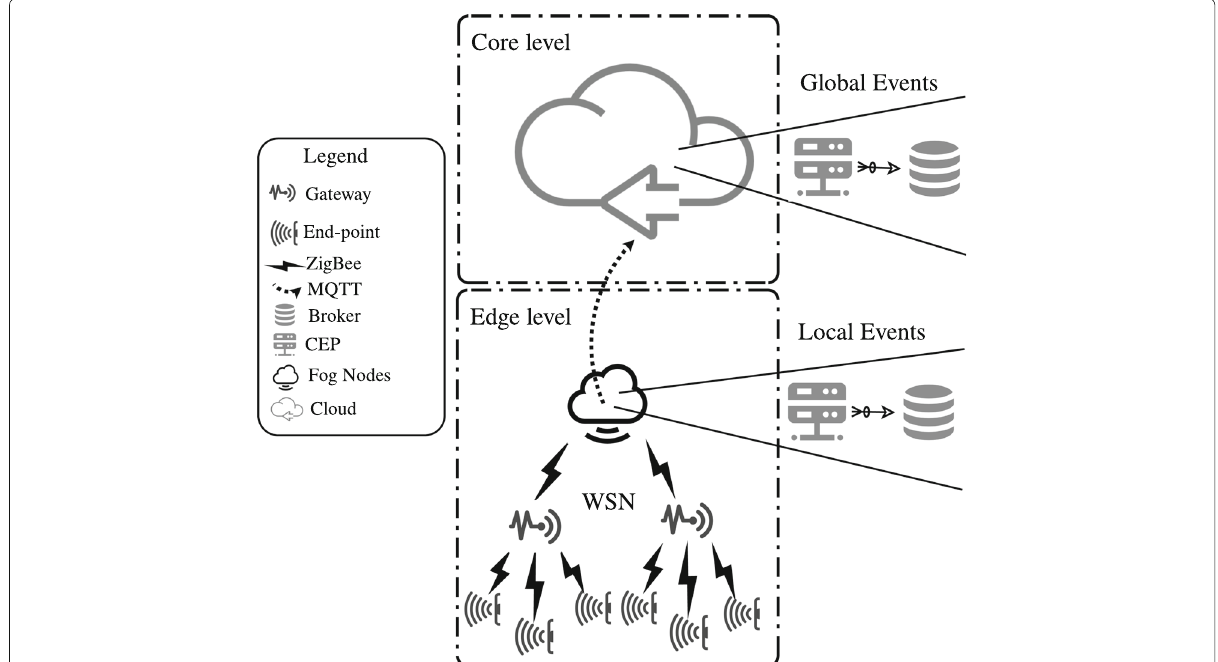
Fig. 3 Telemetry: Local and Global